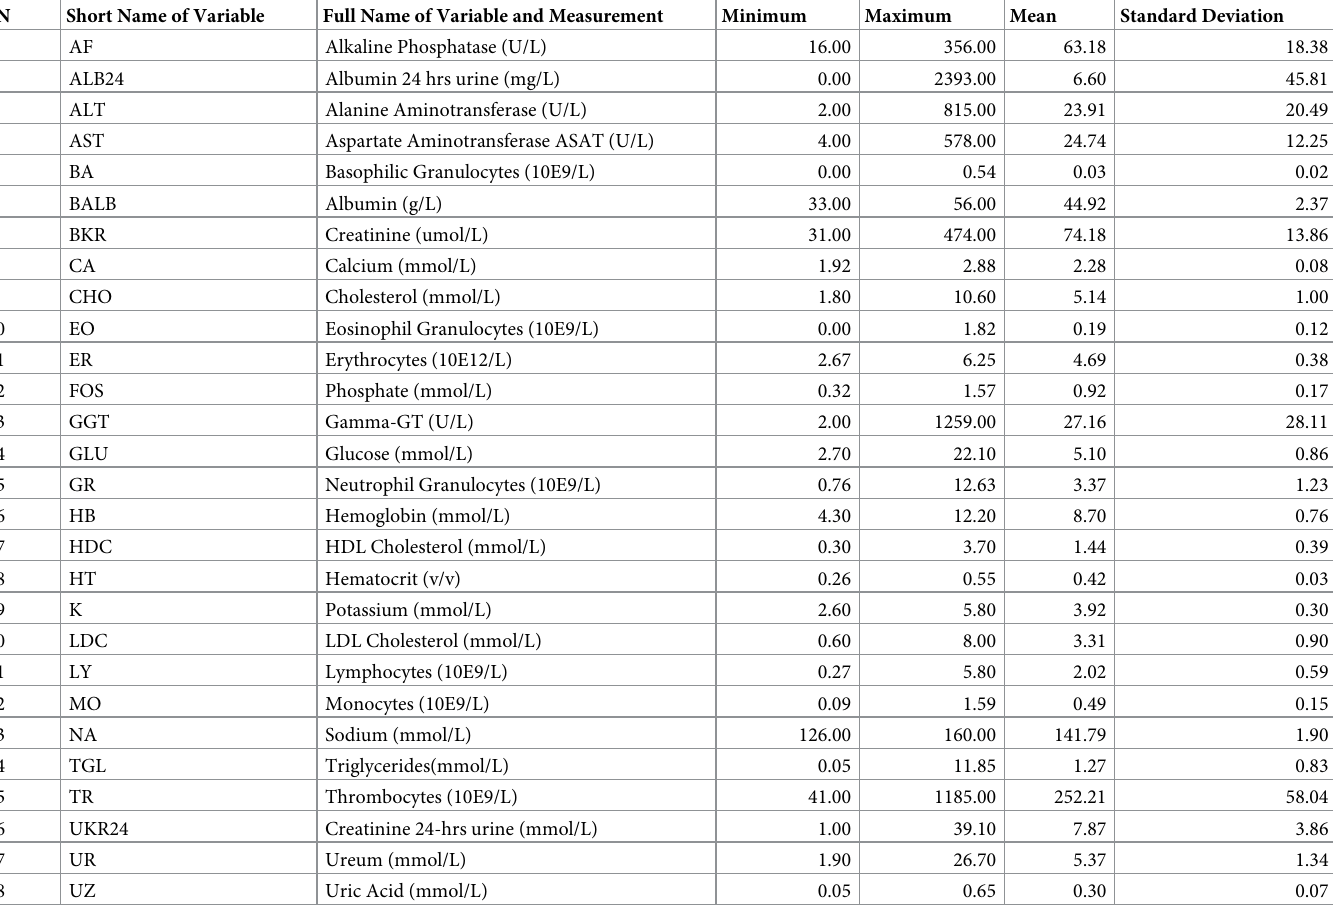
Table 1. Description of predictor